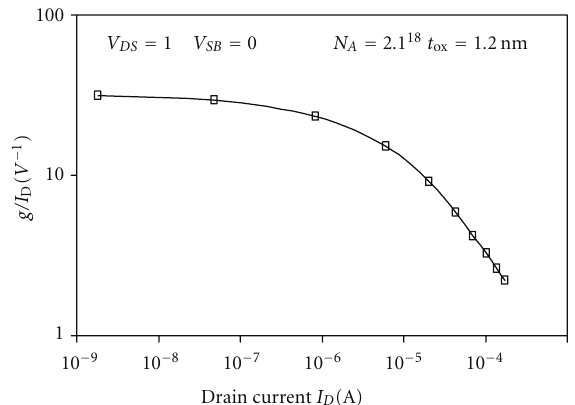
Figure 18: Normalized transconductance [ g/I D , I D ]. V DS = 1 V ; Vg − V fb = 1,1 . 1, ... 2 V ( L = 90nm; W/L = 4). Table 2: The simplified analytic drain current models. Physical constants ε S , ε ox , KT/q Process parameters N A , t ox , μ n , W/L Device